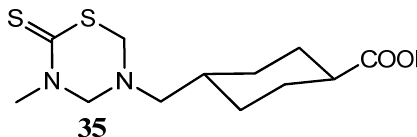
Figure 11. THTT derivative with antimicrobial activity against S. aureus , B. subtilis , E. coli and P. aeruginosa